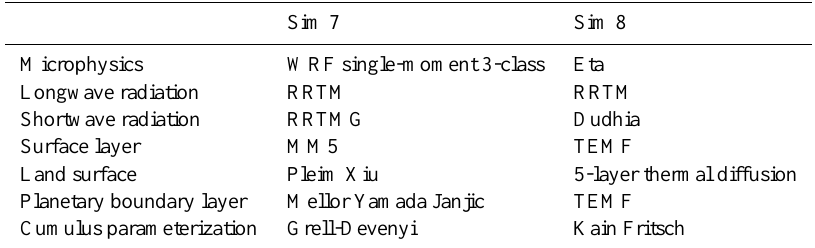
Table 8. Two simulations introduced by other